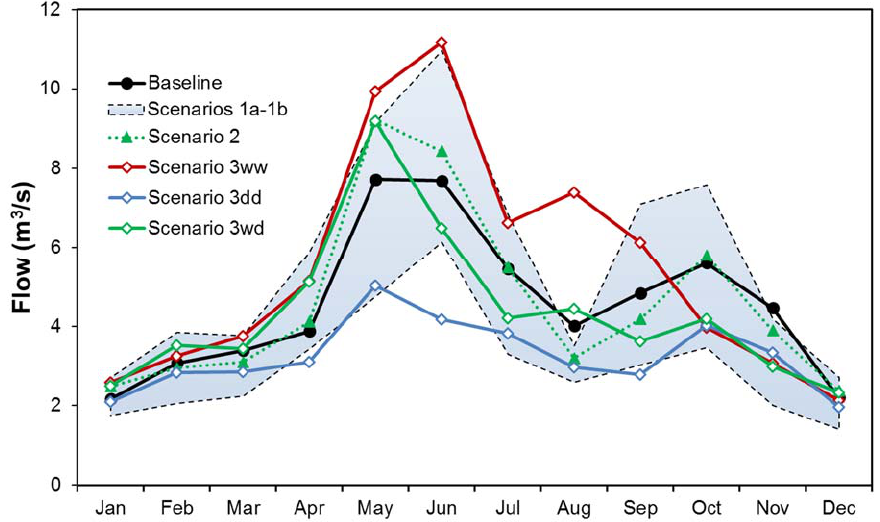
Figure 4. Monthly average streamflow (2046 to 2065) for the baseline and six future climate scenarios.